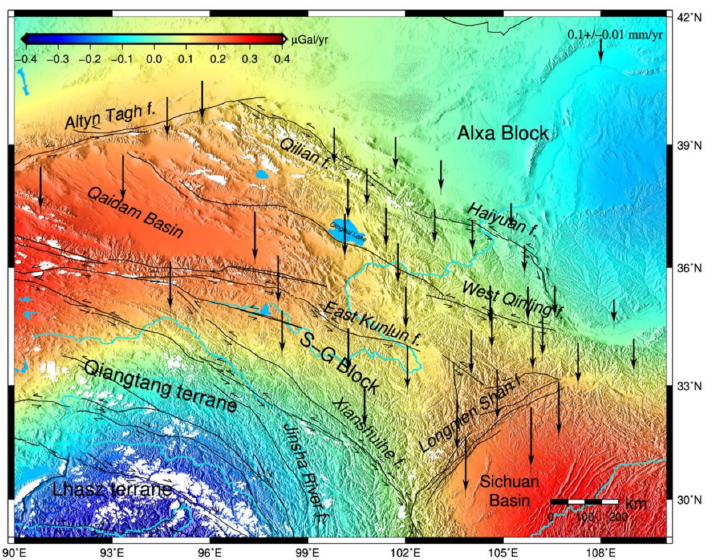
Figure 7. The CSR RL06 GRACE-derived mass change in terms of the secular trend of gravity change (colored background) from April 2002 to June 2017; black arrows denote elastic displacement in height, mainly caused by the surface mass redistribution, and thin black vertical lines are the rms. Glaciers on the Tibetan Plateau are marked as white dots, and lakes are marked as light blue